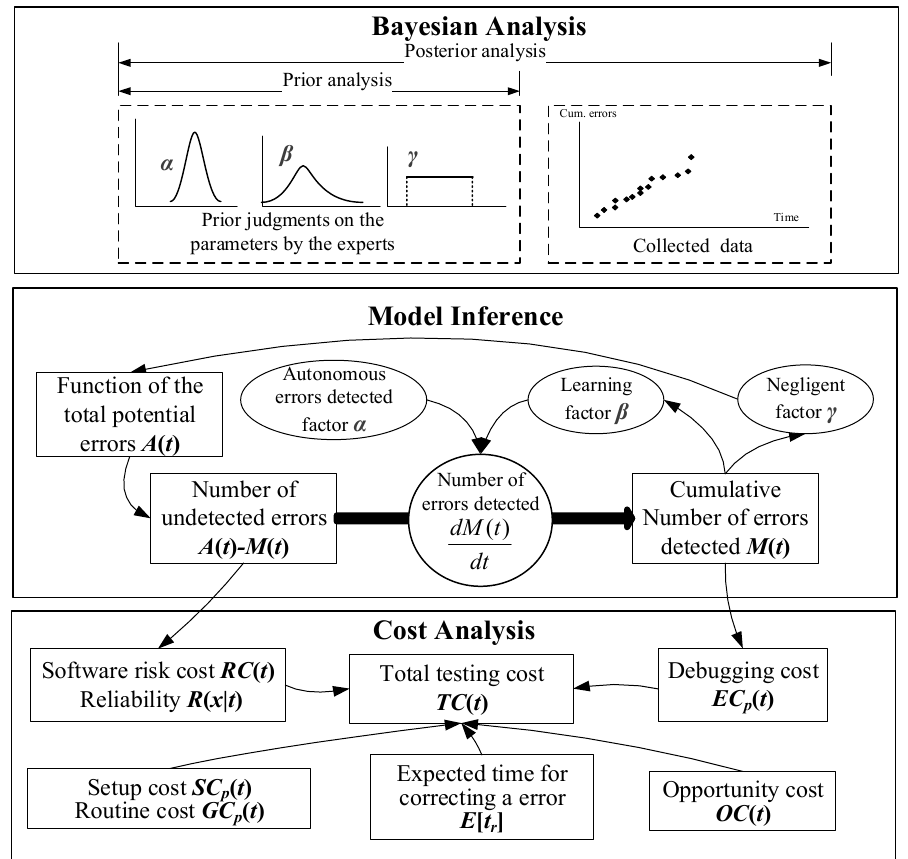
Figure 1. The framework of the study.